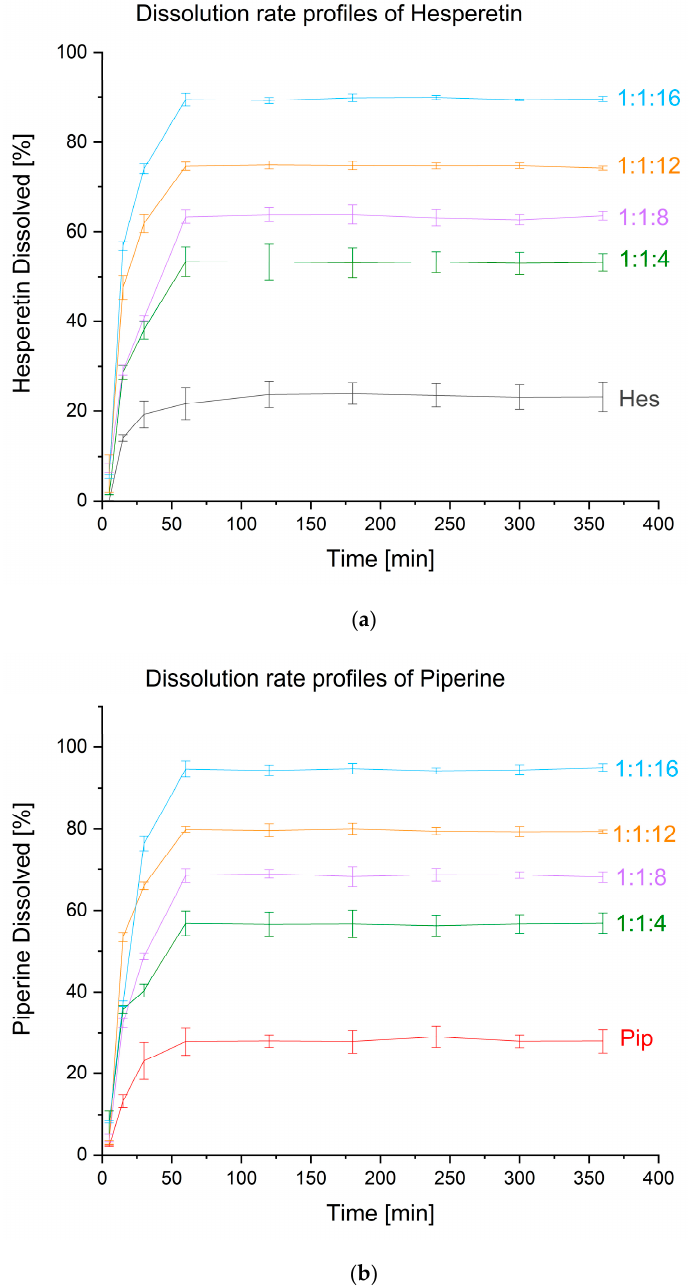
Figure 4. Dissolution rate profiles for amorphous systems of hesperetin ( a ) and piperine ( b ). Amorphous systems were named as a mass ratio of individual components, Hes:Pip:VA 64 (Hes: hesperetin, Pip: piperine, and VA 64: PVP VA 64).